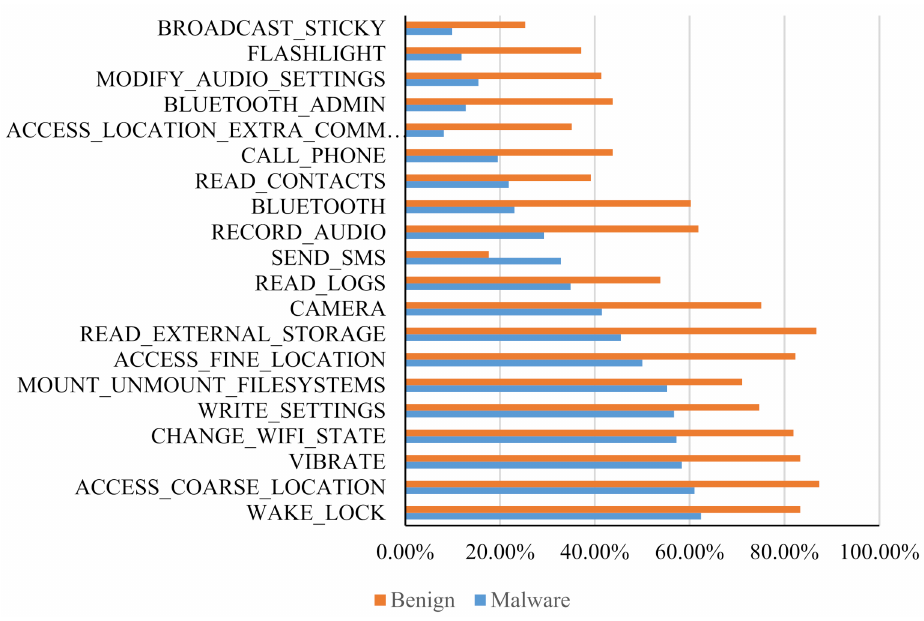
Figure 2. The 20 distinguished permissions selected in this